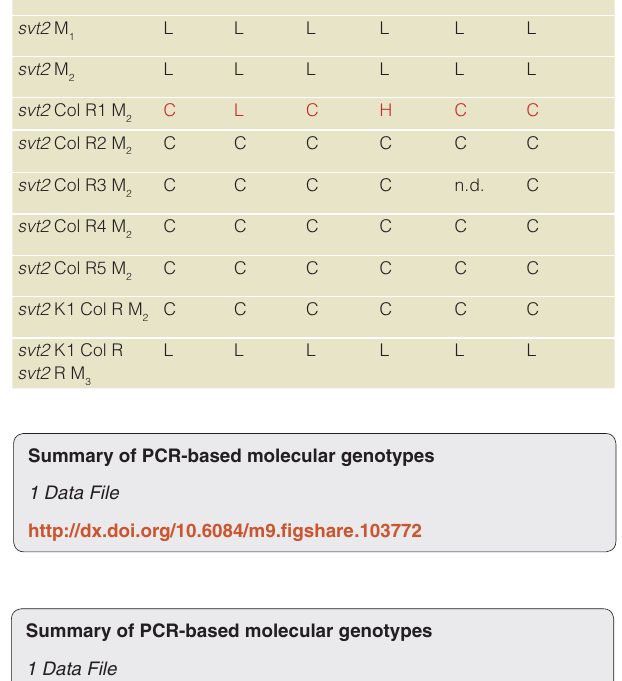
Table 4. Summary of PCR-based molecular genotypes. With the exception of svt2 Col R1 M , where Col and Ler markers and one 2 heterozygous marker were found (highlighted in red), phenotype matched genotype. That is, a Col-like phenotype correlated with the presence of Col polymorphisms, while a Ler-like phenotype correlated with Ler polymorphisms. C, L, and H refer to Col, Ler, or heterozygous, respectively. R denotes revertant. n.d., not